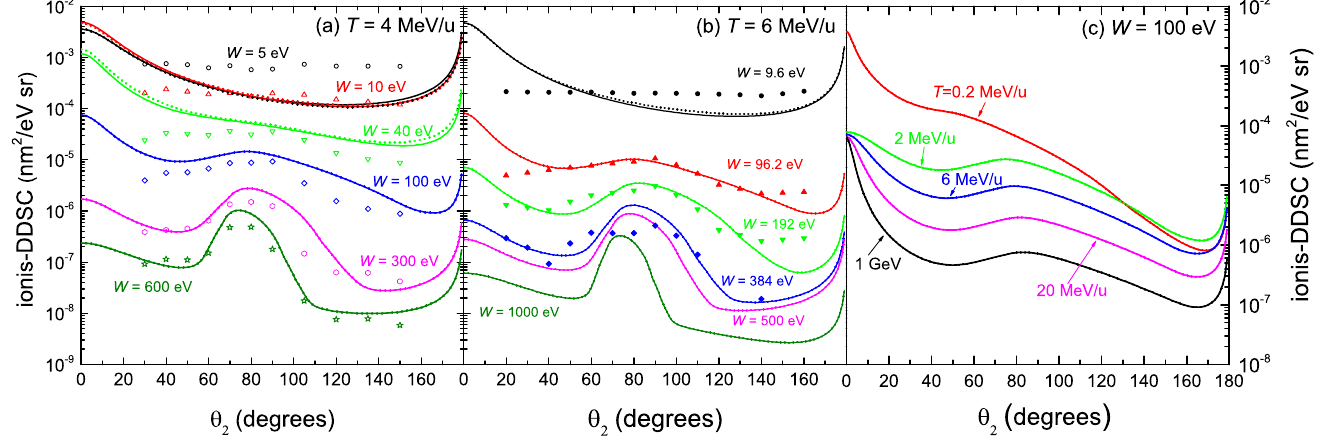
Figure 5. Angular distributions (ionis-DDCS) of emitted electrons by the impact of ( a ) 4 MeV/u and ( b ) 6 MeV/u carbon ions, as a function of the emitted angle θ 2 at different values of the emission energy W . Solid (dotted) lines correspond to our calculations for liquid water using the LR-TDDFT (MELF-GOS) approach, while symbols are experimental data for 4 MeV/u (empty symbols [102]) and 6 MeV/u (full symbols [26]) carbon ions in water vapour. ( c ) Angular distribution (ionis-DDCS) of 100 eV electrons generated by the incidence of carbon ions at several energies T in liquid